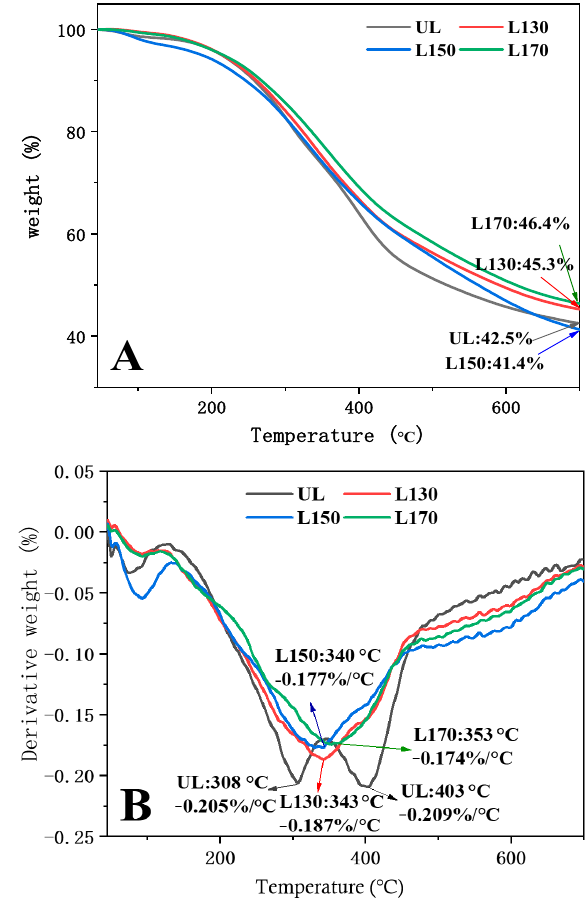
Figure 3. TG curves ( A ) and DTG ( B ) curves for UL, L130, L150, and L170 fractions.